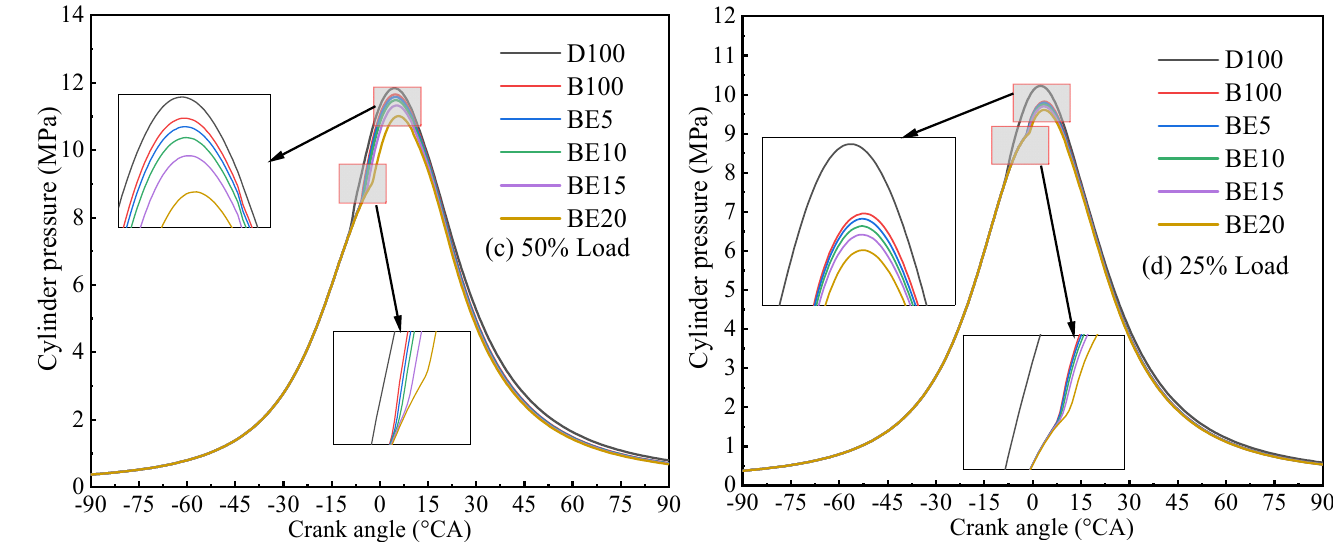
Figure 11. Comparison of cylinder pressure for different fuels at different loads. ( a ) 100% Load, ( b ) 75% Load, ( c ) 50% Load, ( d ) 25% Load.